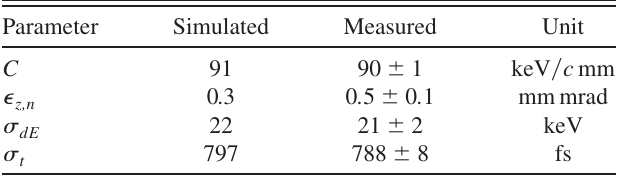
TABLE I. LPS parameter